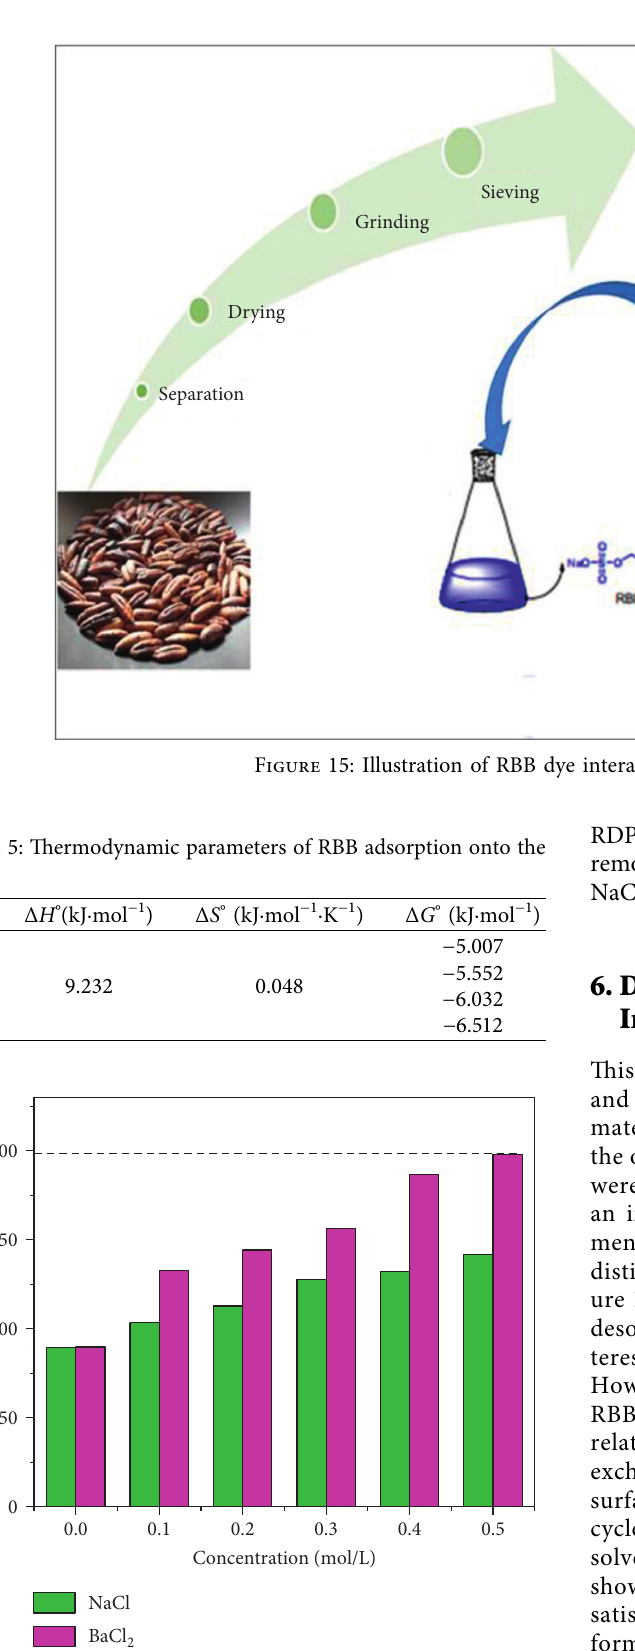
Figure 16: Effect of ionic strength on the removal of RBB onto